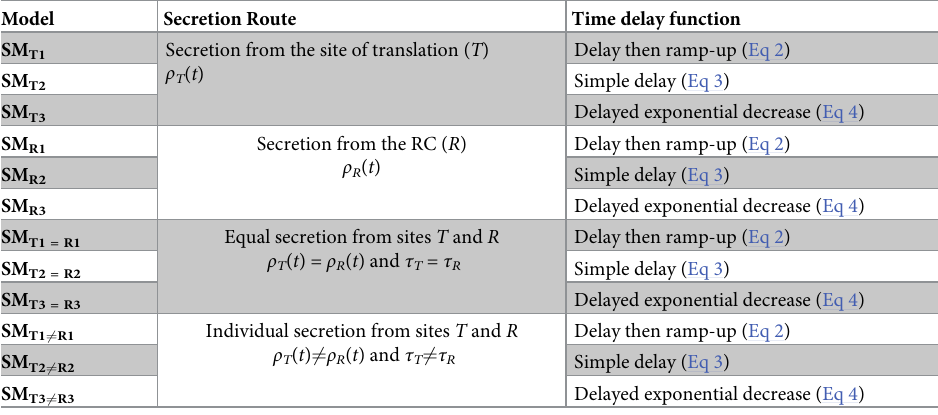
Table 1. Secretion model variants. Overview of the different vRNA secretion models (SM) with different secretion routes and time delay